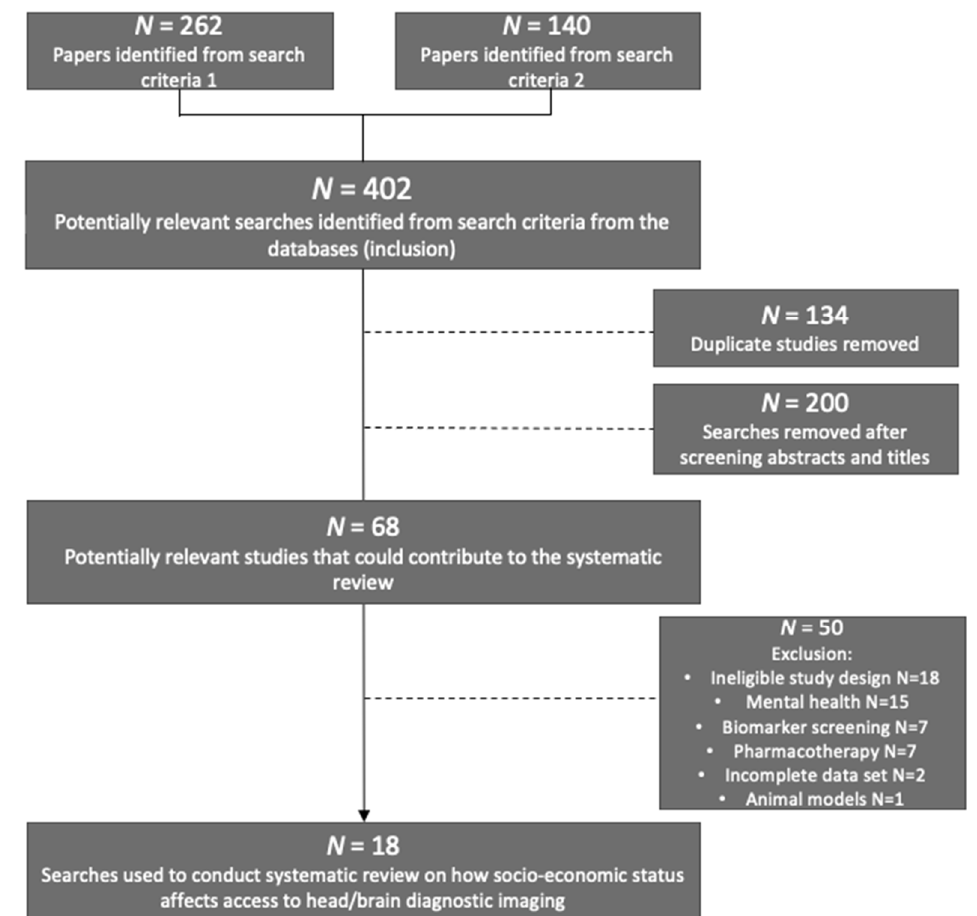
Figure 1. Flow chart to show the inclusion and exclusion of